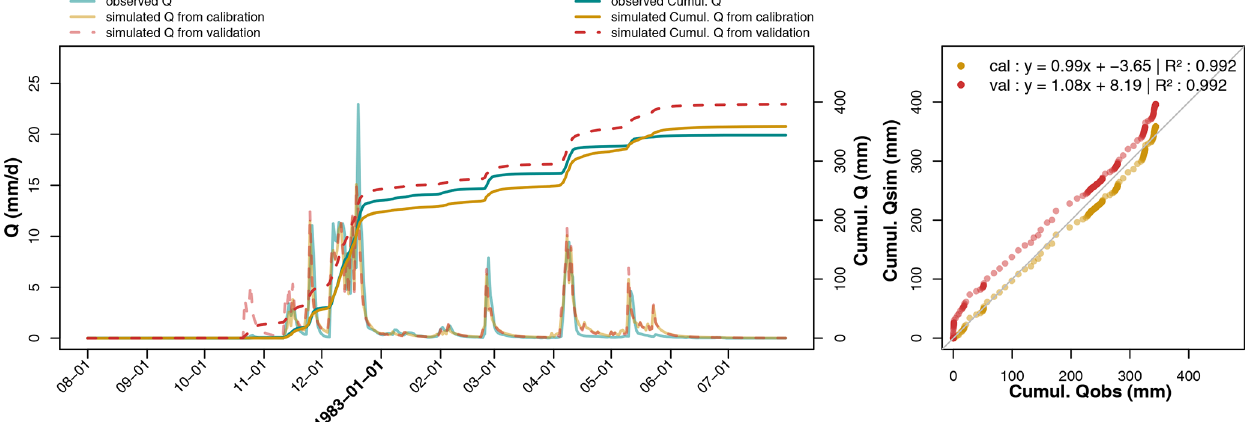
Figure D1. Hydrographs of observed and predicted discharges on the calibration (parameter set derived from sub-period P2) and evaluation (parameter set from sub-period P1) recorded at Saint_Laurent_P2 in 1982–1983. Predicted cumulative discharges are directly compared to